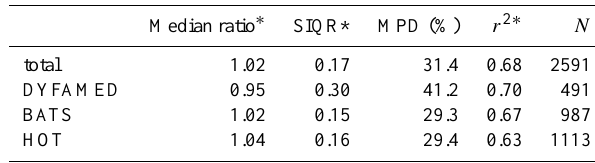
Table 3. Comparison of “satellite-corrected” Chl a C with con- comitant HPLC values. The median “satellite-corrected” to HPLC Chl a C ratio, the semi-interquartile range (SIQR) measured on the previous series of ratio, the median percent difference (MPD) be- tween “satellite-corrected” and HPLC data, as well as determina- tion coefficient ( r 2 ) of the regression performed between “satellite- corrected” and HPLC data points are reported. N indicates the num- ber of couples of data points available. ∗ refers to the variables that were calculated on log-transformed